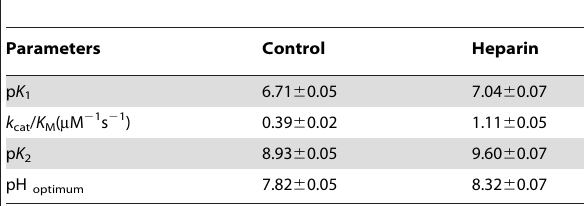
Table 3. Effect of heparin upon the ionization constants of prototropic groups from the human neutrophil elastase active